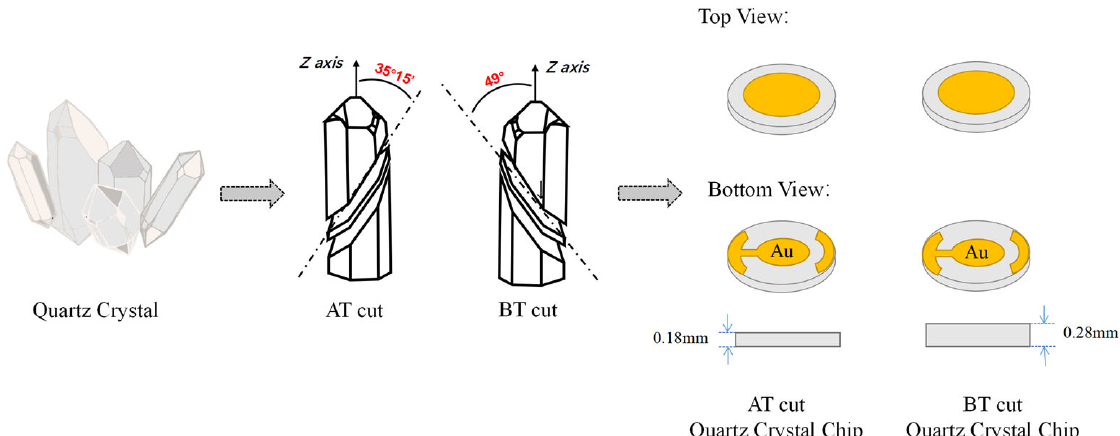
Scheme 1. Schematic illustrations of AT and BT cut crystals. AT cut quartz crystal is cut at an angle of 35°15 ′ relative to the Z axis, whereas BT cut quartz crystal is cut at an angle of − 49°relative to the Z axis. The crystal blanks are then cut in their respective orientations to the crystal axis before being machined and completed to the required sizes.